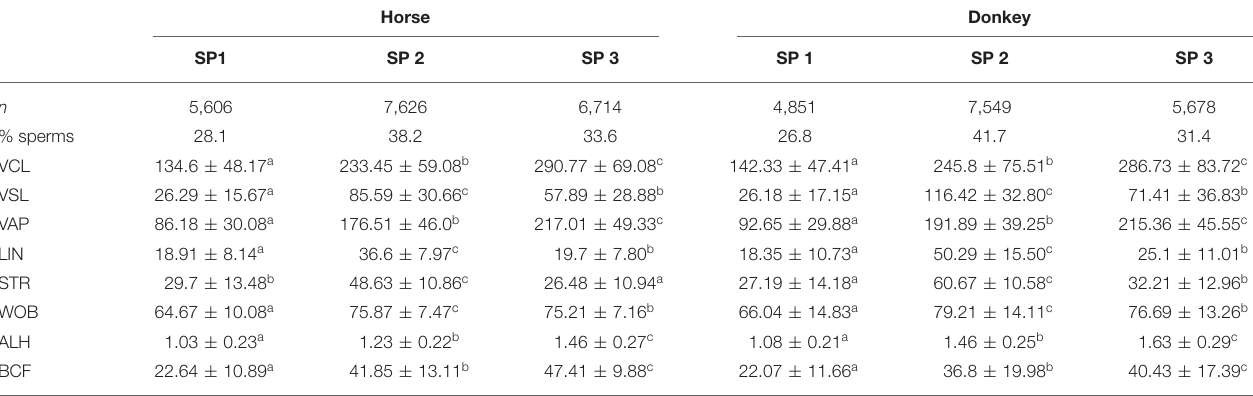
TABLE 3 | Descriptive statistics for the CASA-Mot variables (mean ± SD) for each sperm subpopulation species, horse, and donkey samples. Horse Donkey